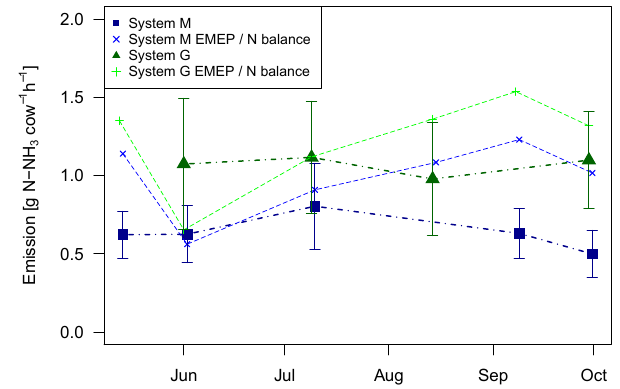
Figure 11. Emissions per cow and grazing hour for system M and system G. Measured values (thick dots and lines) in comparison to estimated values based on urine N amount from the N balance model and the EMEP standard emission factor for NH 3 (10%; see EMEP/EEA, 2016). The error bars (2 σ ) were calculated based on the methodological uncertainty (Sect. 3.3.1) and on excreta density uncertainty in the single rotations (Sect.